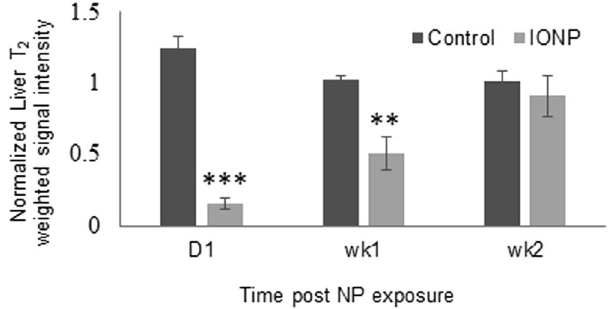
Figure 8. Quantification of the signal intensity of the specific region of interest defined as the liver, as evaluated from the MR images in mice administered PBS (control) and mice administered 60 µ g Fe of IONP-DHCA after 1 d, 1 wk and 2 wk post IONP exposure. The signal was normalized against muscle tissue around the vertebra column. The analysis was conducted in replicates of three mice per condition over 2 wk. The degree of significance is measured using GraphPad Prism software and is indicated when appropriate * P < 0.05, ** P < 0.01 and *** P < 0.001 ( one - way ANOVA , Dunnett post-hoc